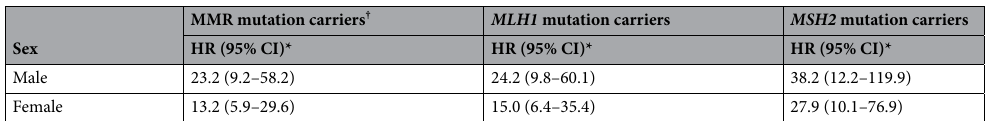
Table 2. The sex-specific estimates of hazard ratios (HR) for colorectal cancer risk in specific mutation carriers compared to non-mutation carriers. MMR ; Mismatch repair genes. † Including MLH1 and MSH2. *Estimation of HR was adjusted for ethnicity and physical activity.